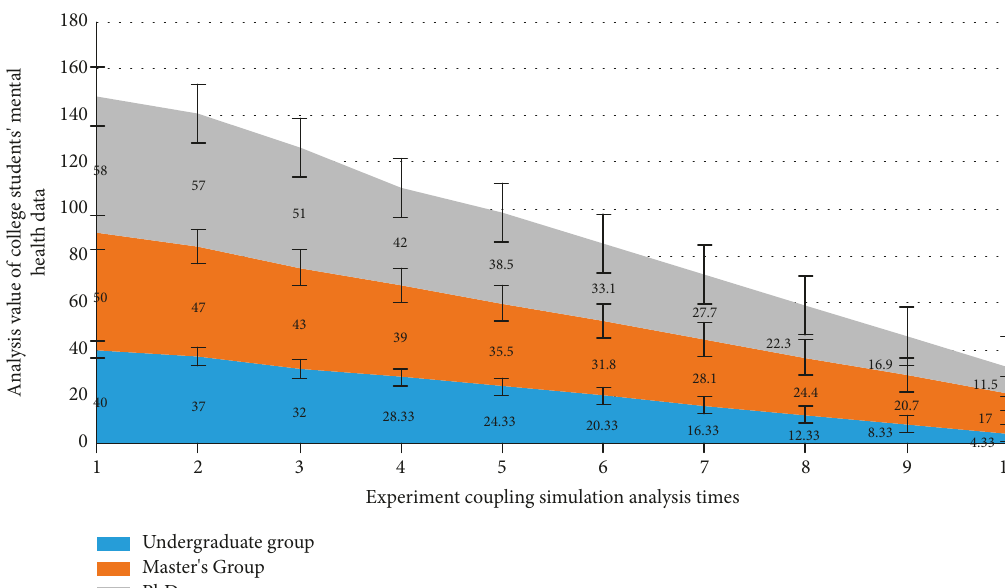
Figure 6: Data analysis results after analyzing the mental health of different college students with the same model under deep learning.